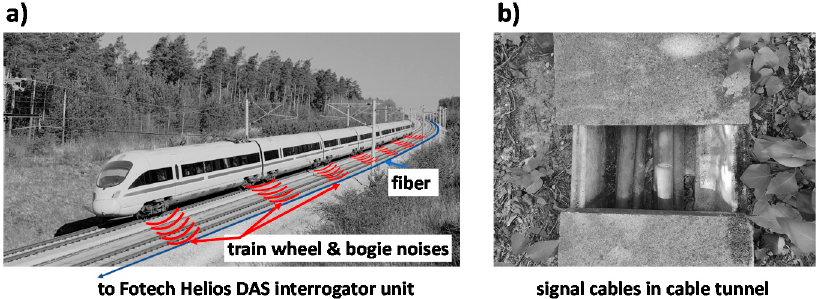
Figure 1. ( a ) Schematic of ICE train on ballastless track emitting noises that are picked up by a fiber optic distributed acoustic sensing (DAS) interrogator. ( b ) Standard telecom signal cables lying within cable tunnels are used for sensing.